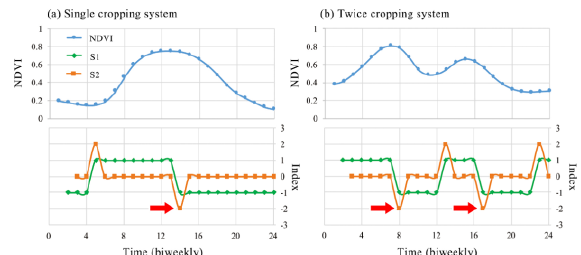
Figure S3. Calculation of the MCI using double subtraction algorithm. The original NDVI data (blue lines) with 24 points in a complete year were first stacked in a column, then a dislocation phase subtraction with one temporal phase was applied to original time series (e.g., t2-t1, t3-t2), this produced a new temporal profile (green lines named as S1). For these 23 points, the positive value was assigned with value of +1, whereas the negative was assigned with -1. Subsequently, a repeated dislocation subtraction with one temporal phase was applied to the previously derived profile, producing a third temporal sequence (orange lines named as S2) with 22 points and the values of the data were -2, 0 and 2. Finally, the -2 points (red arrows) were reported as the peaks of this annual NDVI profile, and the total number of -2 points was nominated as the multiple cropping index (MCI). (a) is the MCI calculation flowchart of single cropping system, and (b) is that of double cropping system.